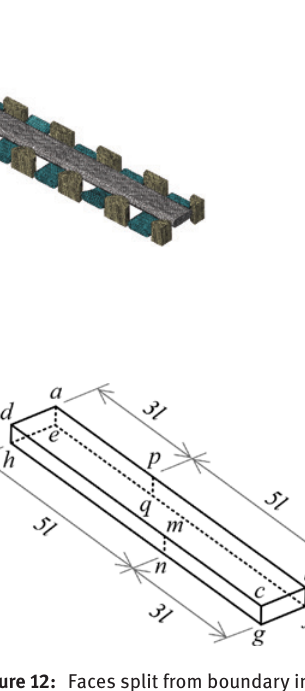
Figure 12: Faces split from boundary in periodic boundary